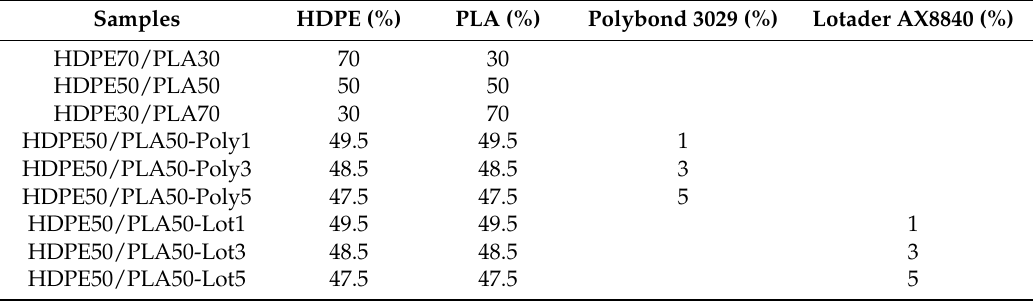
Table 1. Formulations produced (10 samples for each family). HDPE: high-density polyethylene, PLA: poly(lactic)